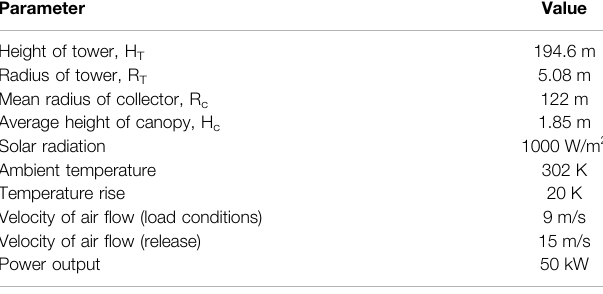
TABLE 1 | Key dimensions and data of the Spanish pilot